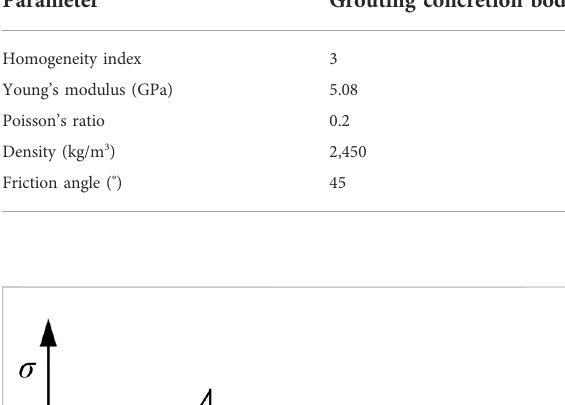
TABLE 1 Physical and mechanical parameters of grouting concretion body.